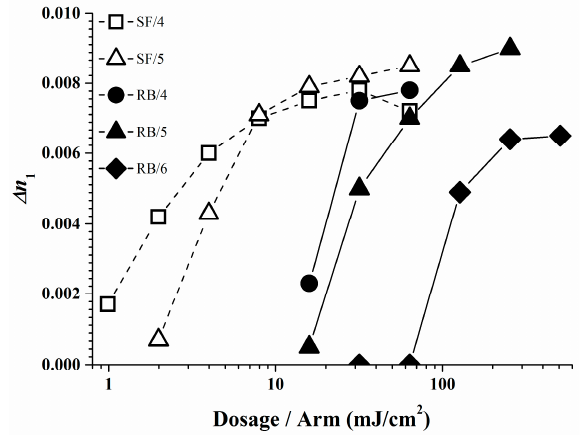
Figure 9. ∆ n 1 as a function of the irradiation dosage per arm [35].